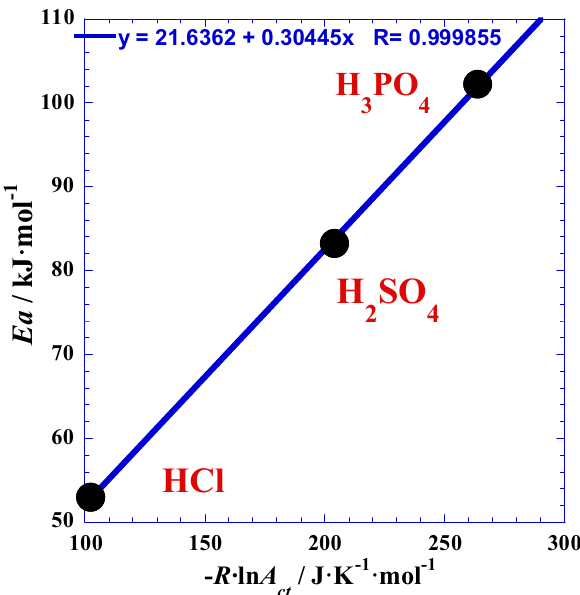
Figure 2. Correlation between the activation energy Ea (kJ/mol) from polarization and impedance measurements 21 and the entropic factor of Arrhenius – R ·ln( A ct / Ω·cm 2 ) / (J/K·mol) for the three acids HCl, H 2 SO 4 and H 3 PO 4 at atmospheric pressure.